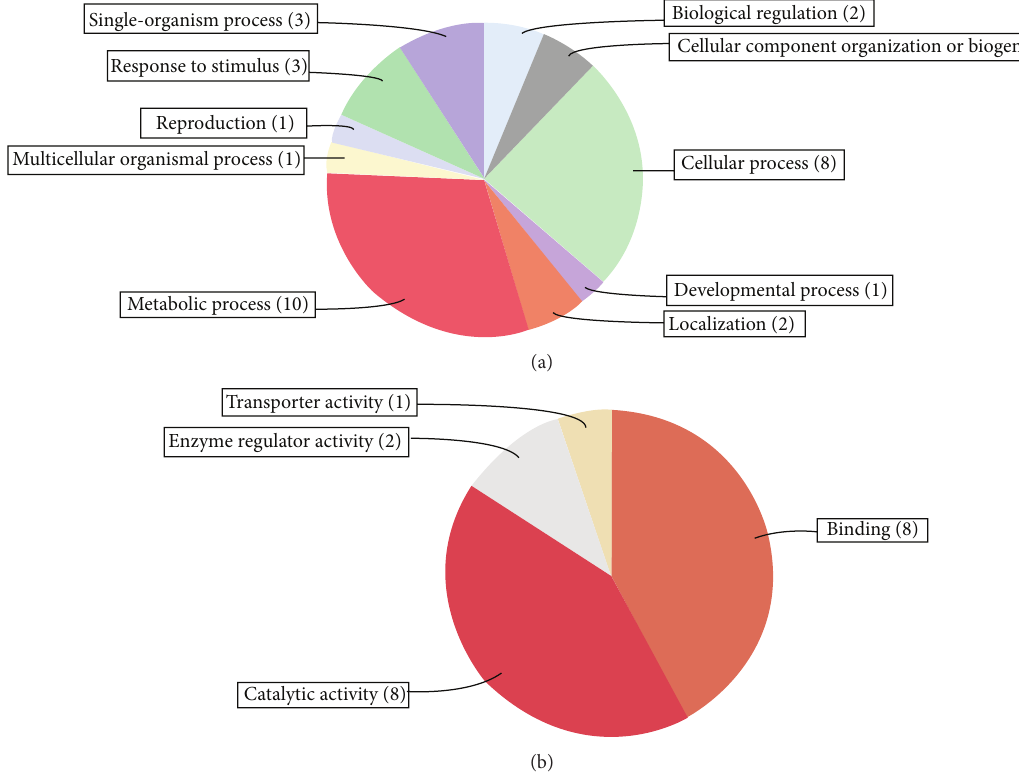
Figure 5: GO (gene ontology) term enrichment analysis of miRNAs target genes. Analysis of miRNAs targets within biological process (a) and molecular function (b)